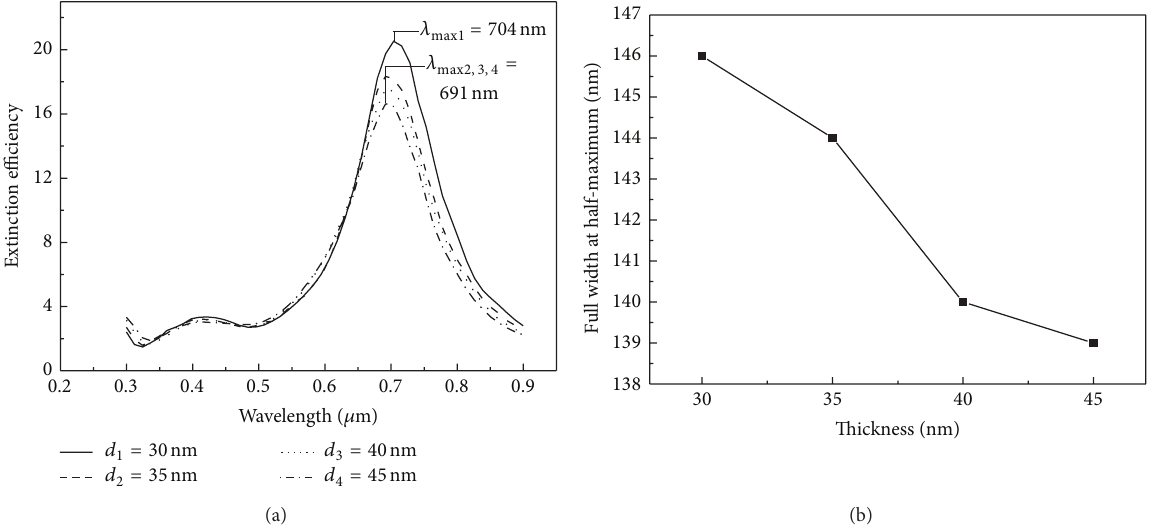
Figure 2: (a) Extinction spectra of triangular Ag nanoparticle arrays for different thicknesses with fixed period of 230 nm. (b) Relationship between the peaks of wavelength and the thicknesses of triangular Ag